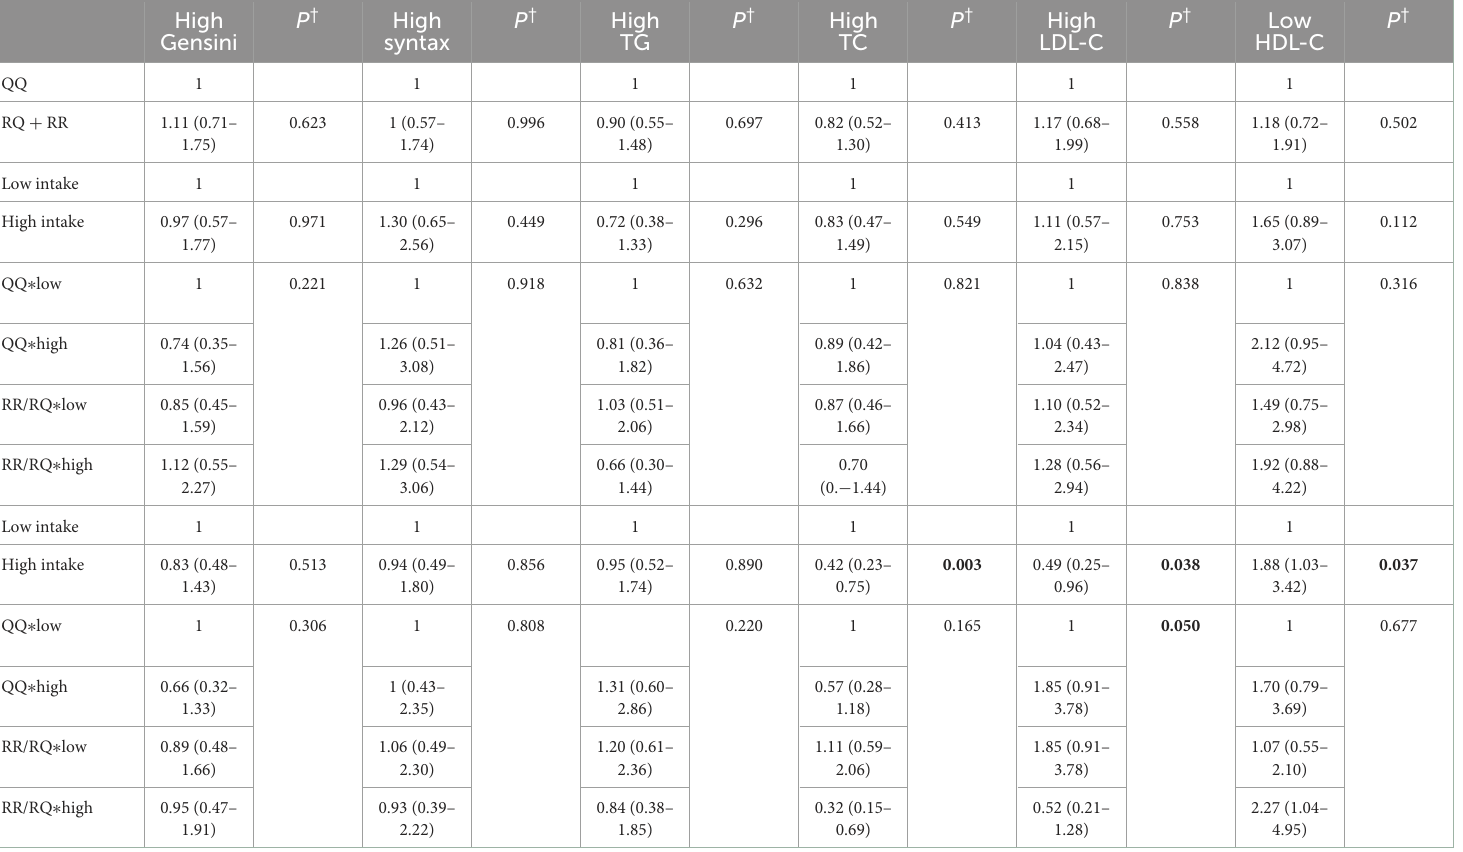
TABLE 3 The odds of CAD severity and its risk factors in terms of vitamin E and C intake, PON1 rs662 genotypes, and the interaction of the vitamin intake and genotypes.